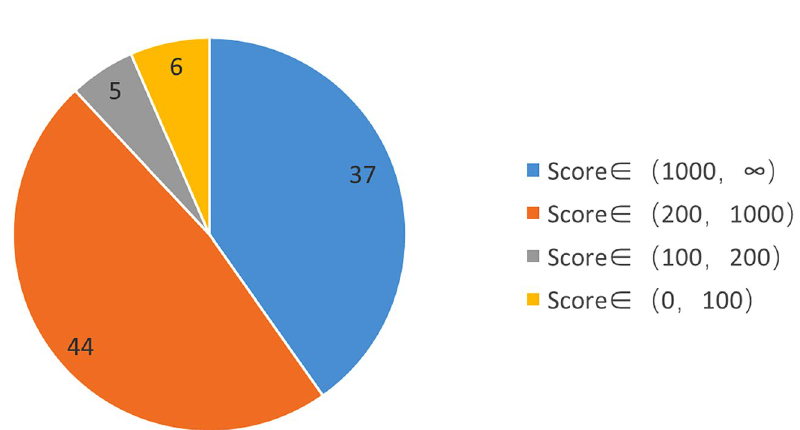
Figure 2. The score of the target protein that LrB acts on BMMs and the proportion of different score segments. (1) Targets with Score > 1000: high-affinity binding, characterized by fast binding and high affinity. Such target proteins are usually related to acute drug efficacy, acute toxicity and drug metabolism; (2) Targets with 200 < Score < 1000 Point: medium-affinity binding, characterized by binding speed and medium affinity, such targets are usually related to chronic drug effects; (3) Targets with 100 < Score < 200: low-affinity binding, characterized by slow binding and relatively low affinity Low, such targets are usually related to drug delivery, blood drug concentration maintenance, and bypass drug efficacy.